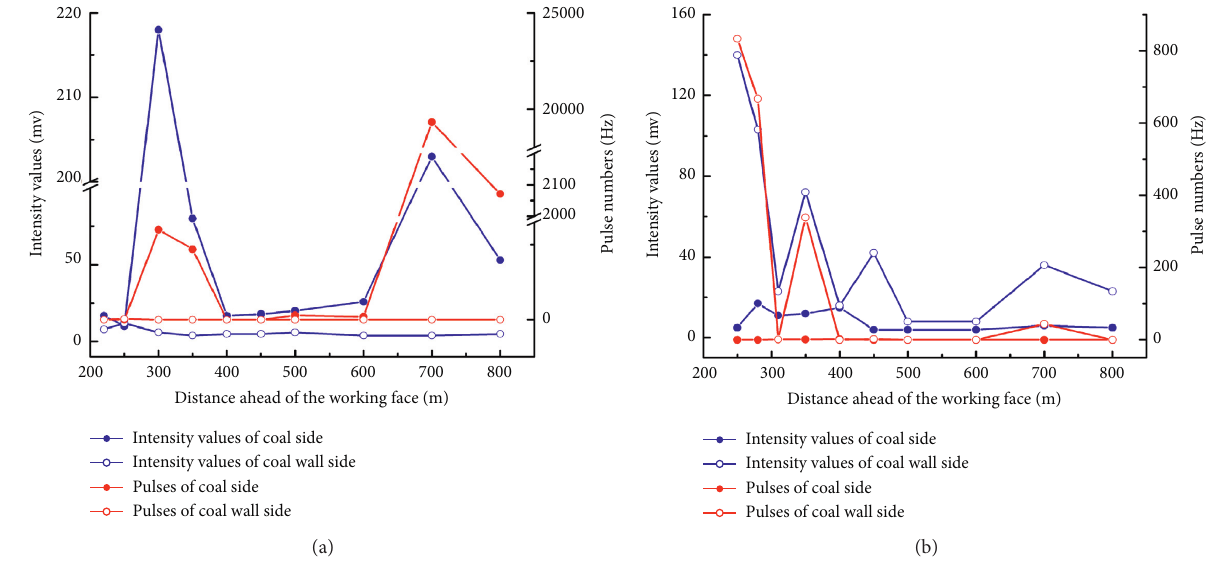
Figure 11: Monitoring results of EMR in 5308 roadway: (a) 2017.12.18; (b)